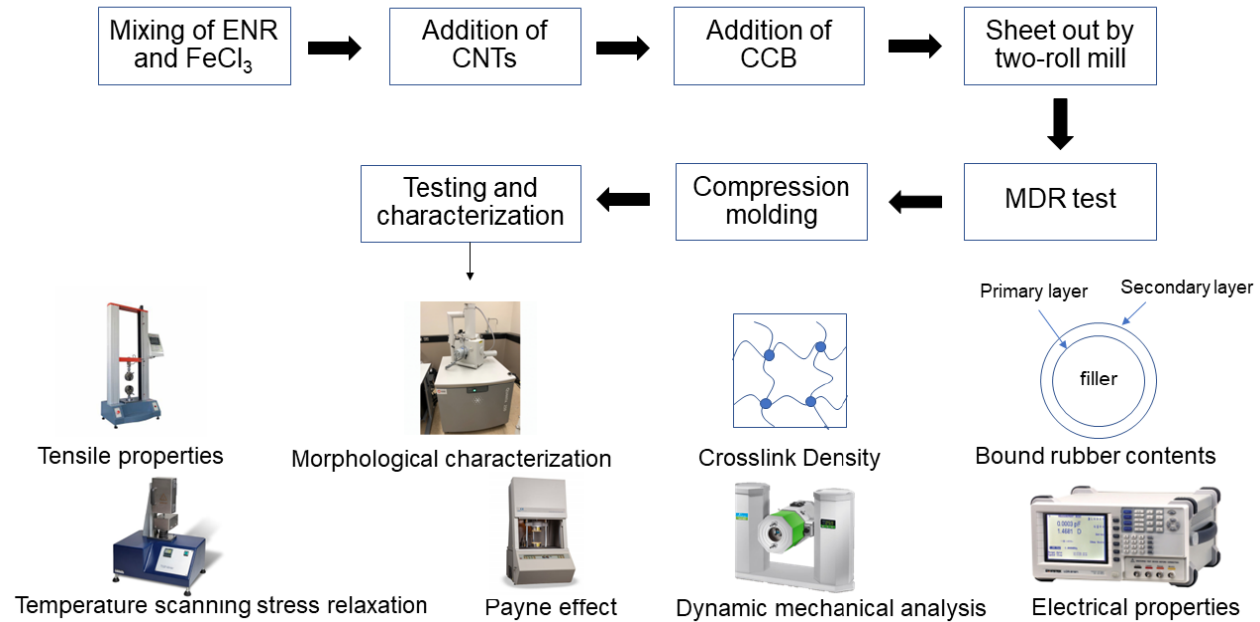
Figure 1 . The compounding and characterization procedures of ENR–FeCl 3 /CNT–CCB hybrid nano ‐ composites